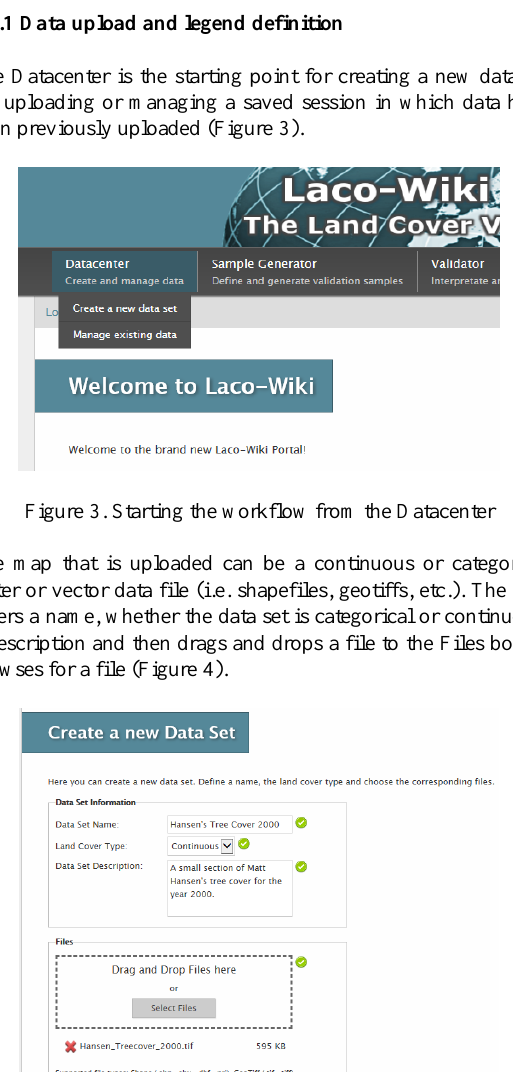
Figure 2. The LACO-Wiki system architecture